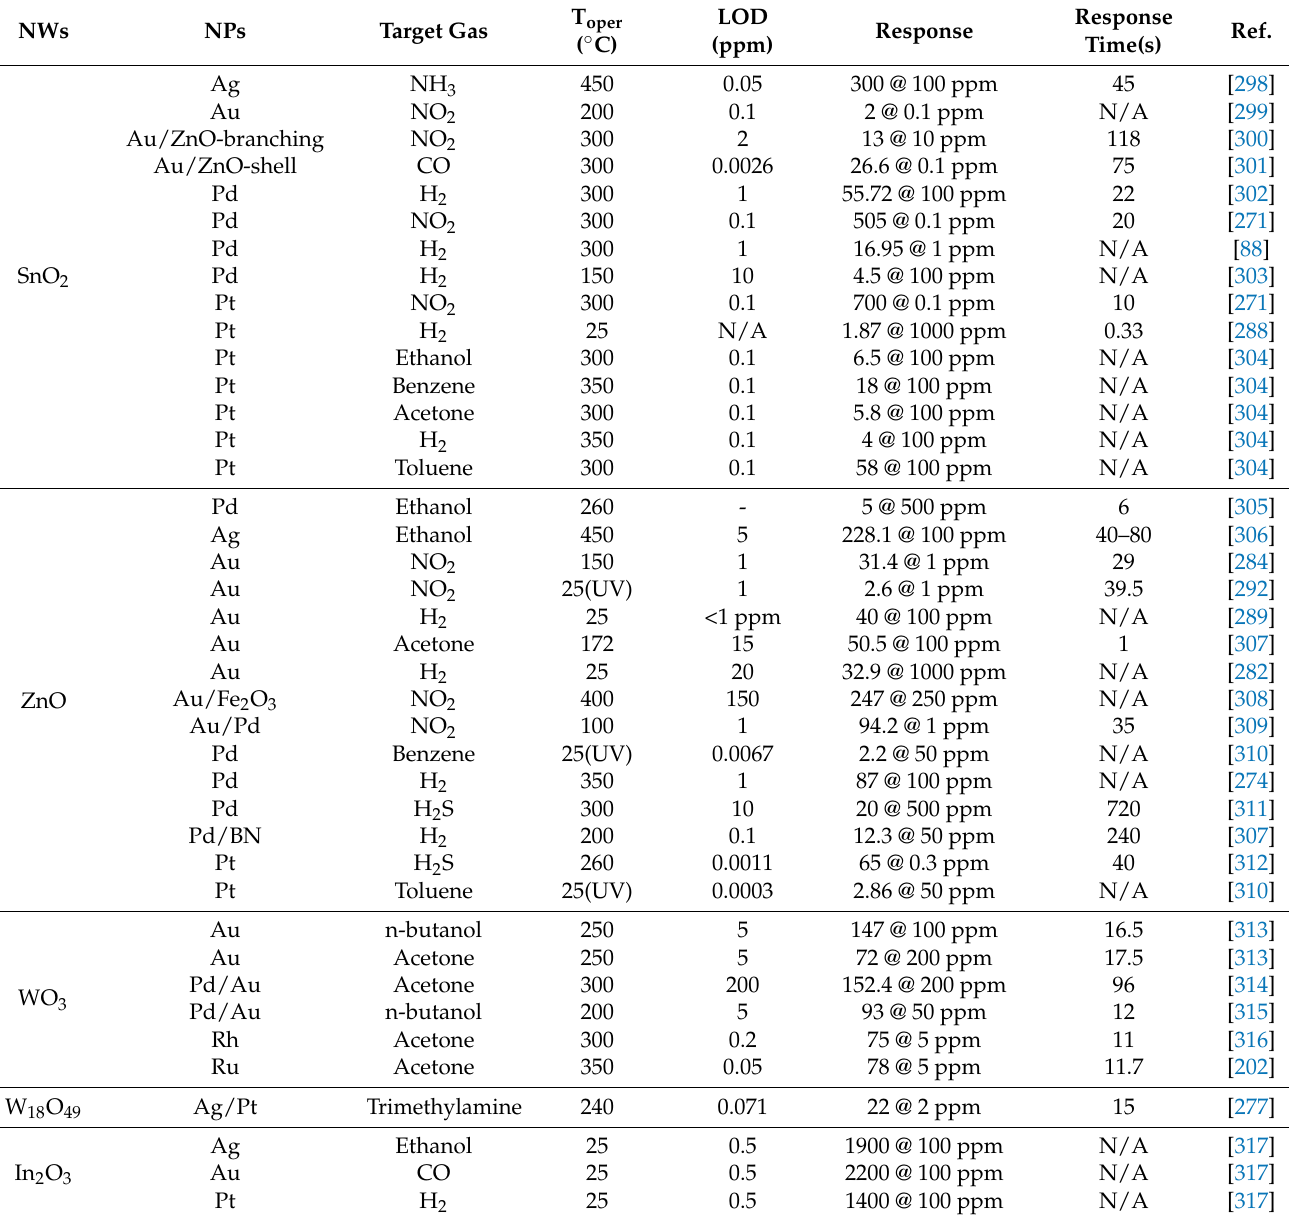
Response Time(s)